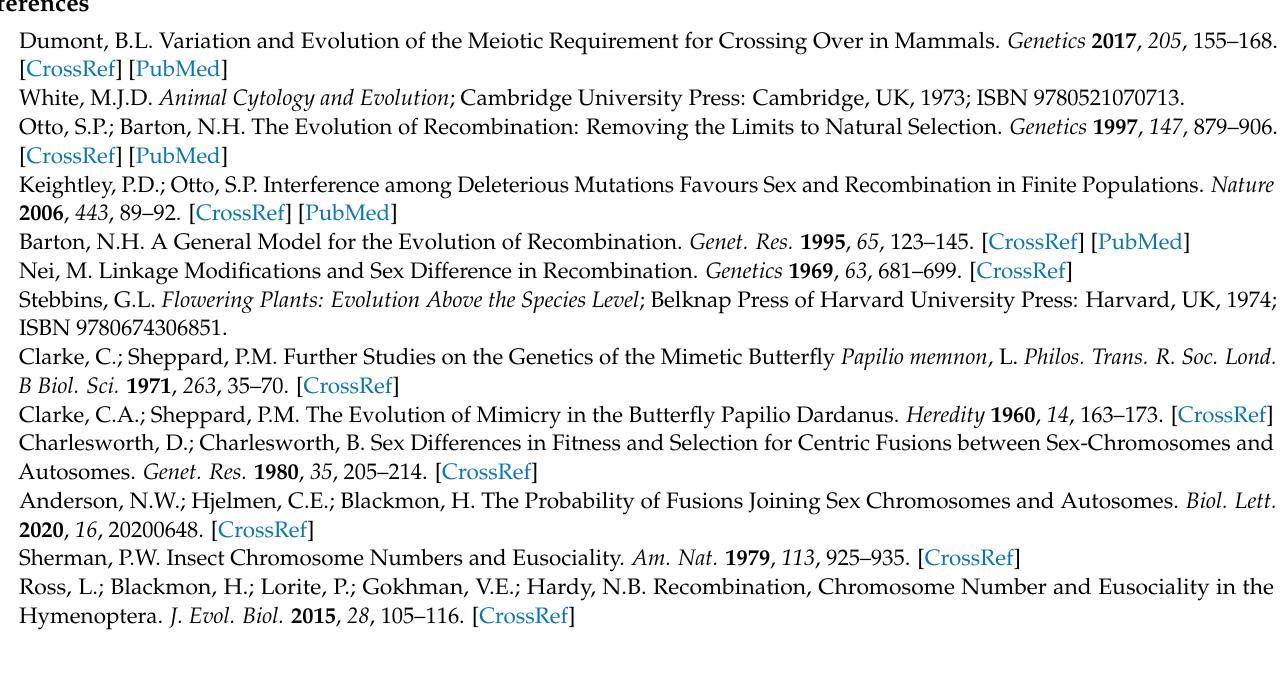
Figure S2: Sensitivity analysis of